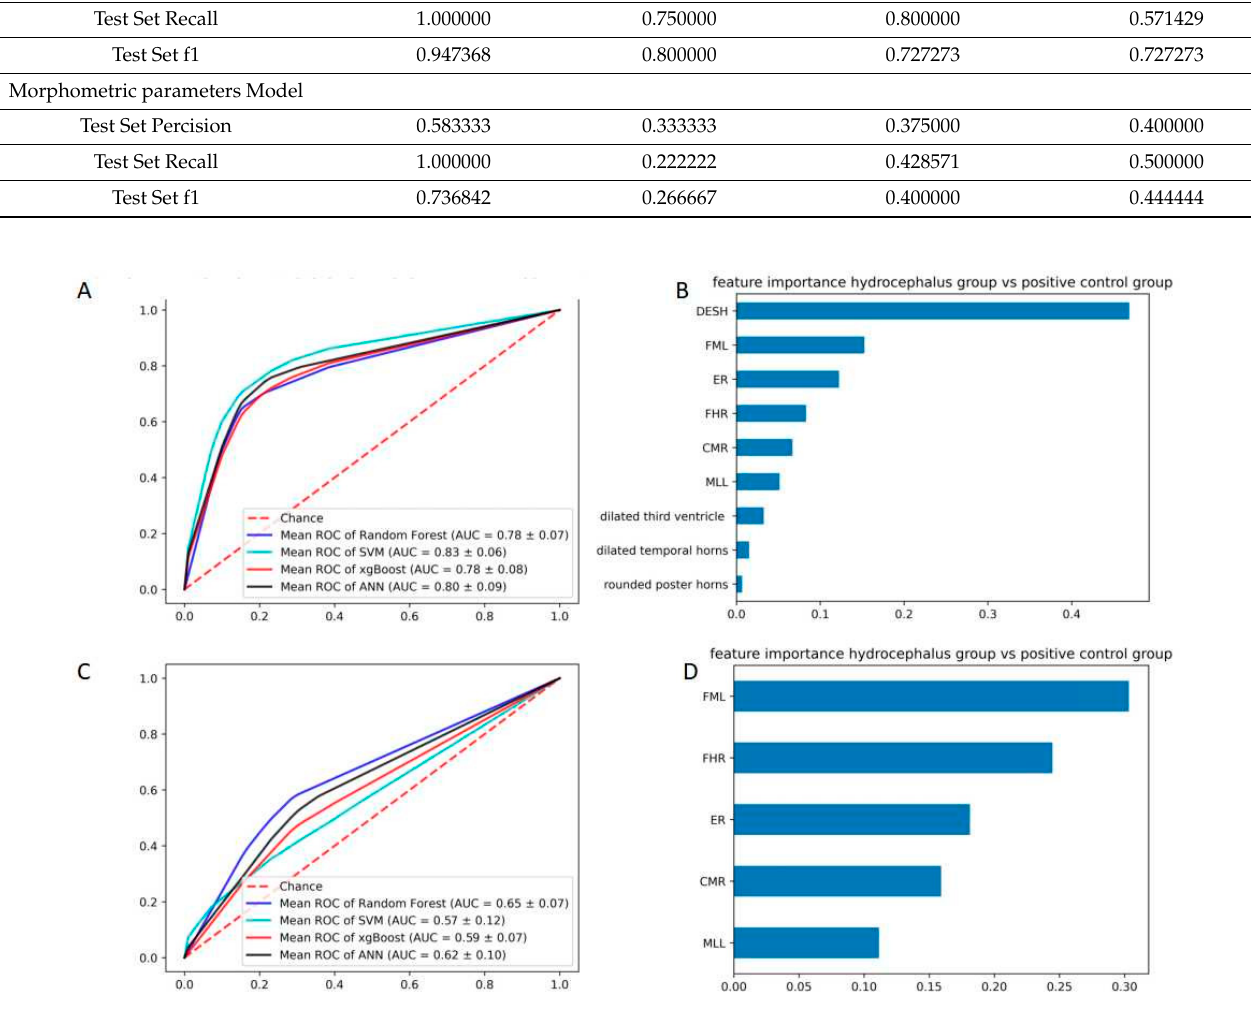
Figure 5. The comparison of hydrocephalus group and symptomatic group in terms of ROC and weight. ( A ) ROC curves of the four derived models with all features: RF, random forest, XG, XGBoost; ANN, artificial neural network; SVM, support vector machine for the patients with hydrocephalus and normal control; ( B ) The weight of all features; ( C ) ROC curves of the four derived models with morphometric parameters; ( D ) The weight of all features morphometric parameters.